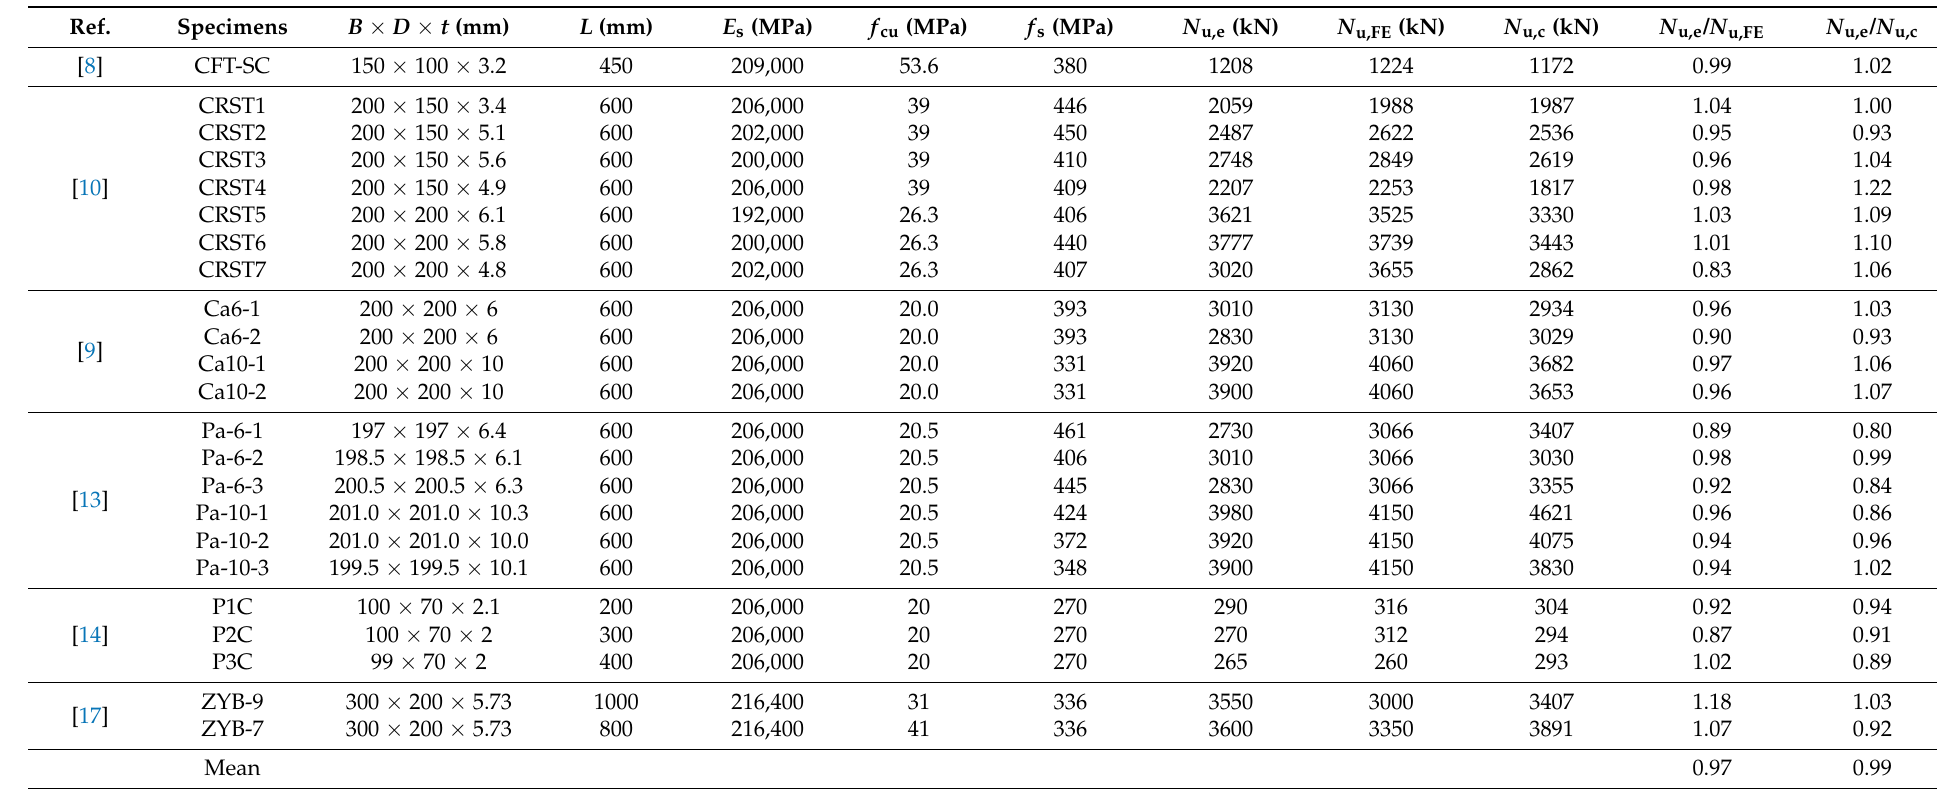
Table 1. Comparison of experimental results in references, FE results, and calculated